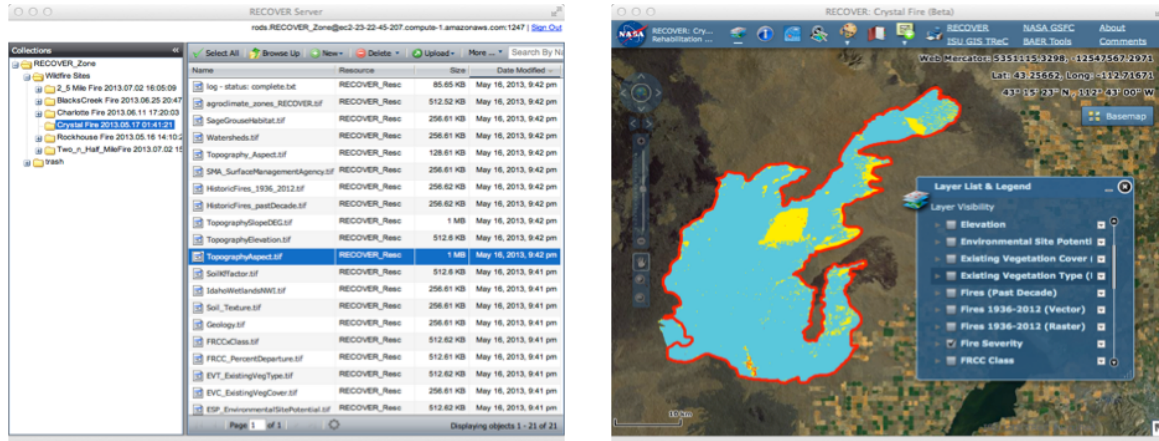
Figure 1. RECOVER Server and Client interfaces. For YouTube demonstrations, please